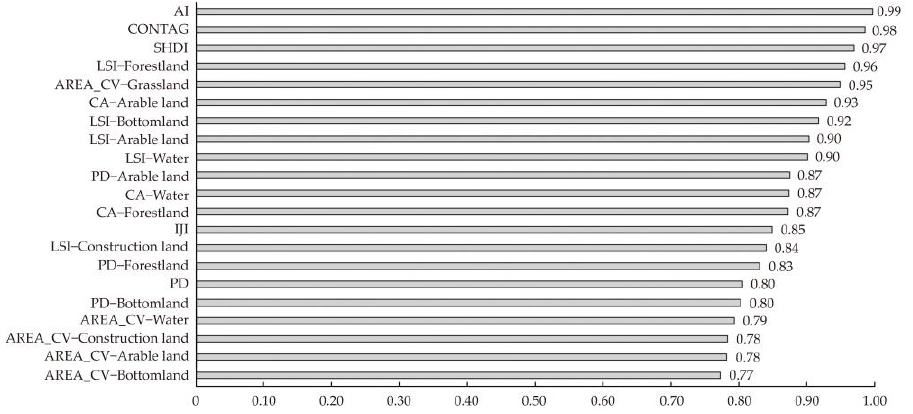
Figure 9. Grey relation coefficient between landscape index and habitat quality.